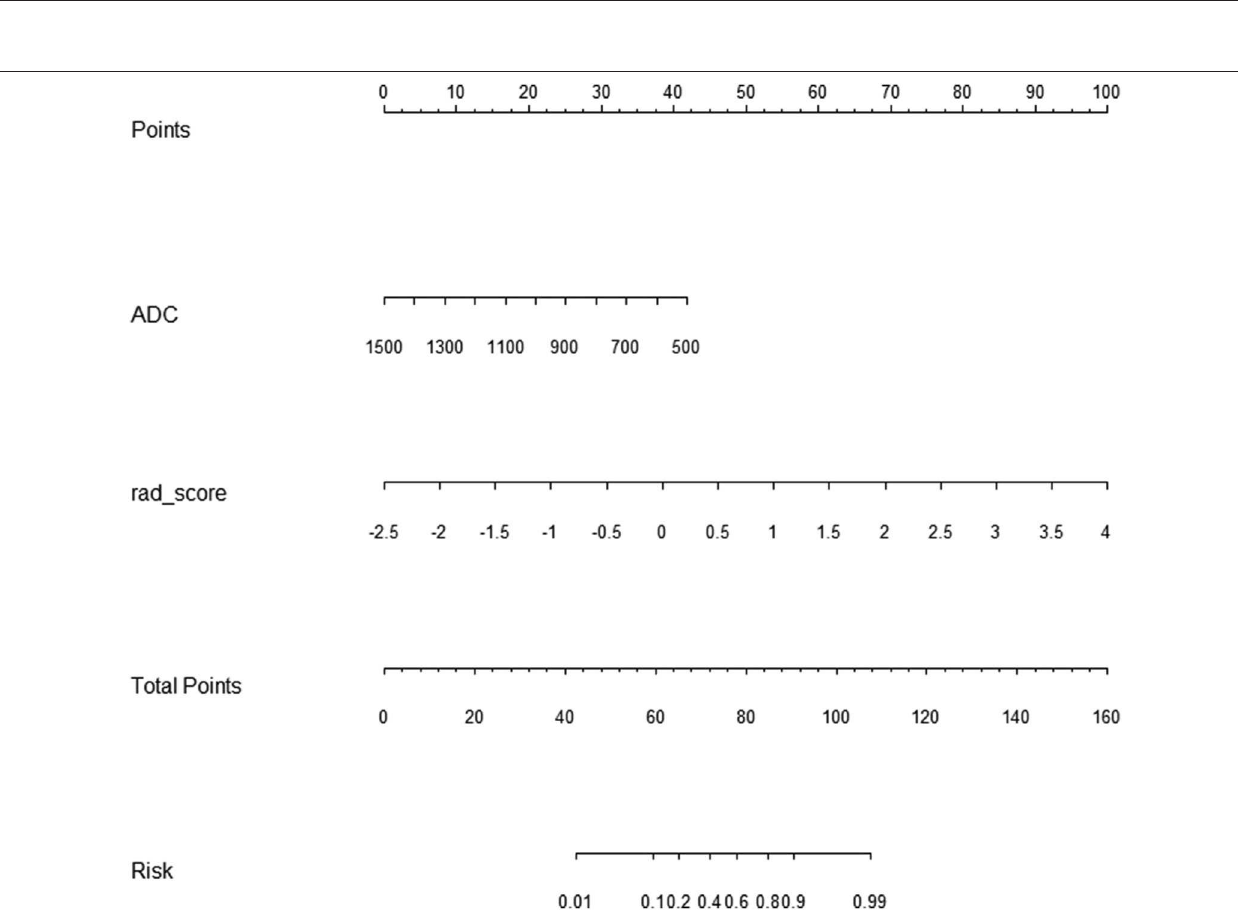
Frontiers in Oncology | www.frontiersin.org